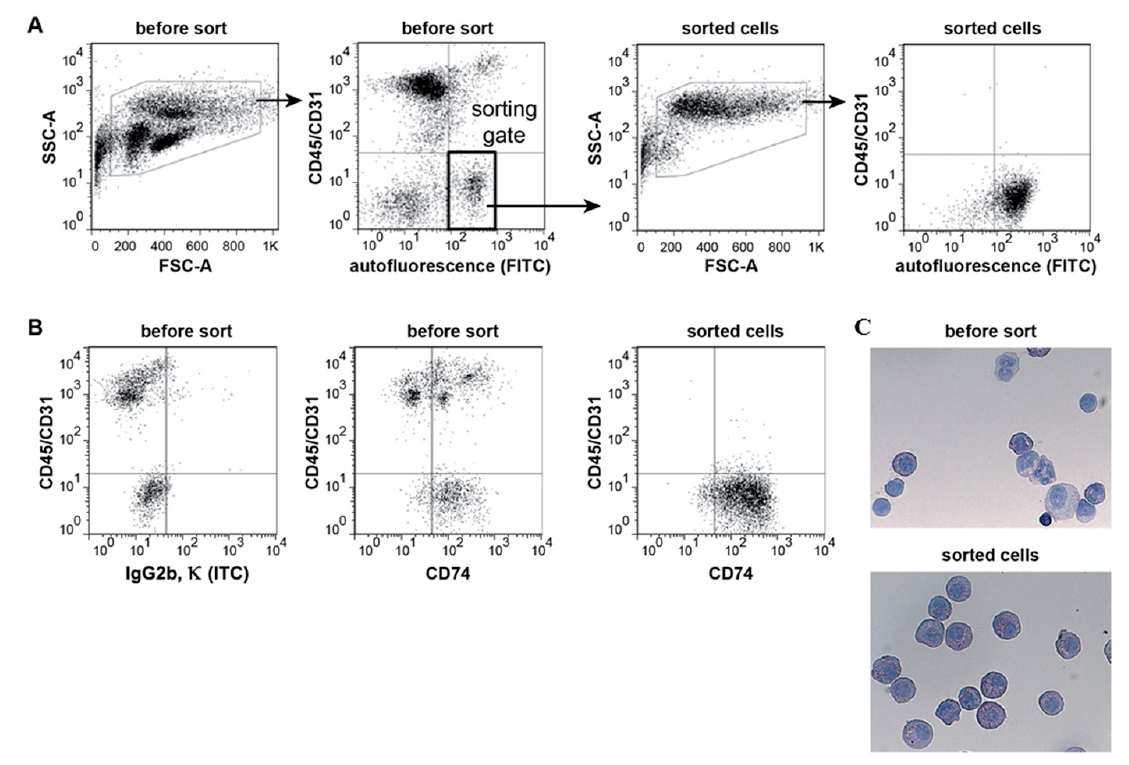
Figure 1. FACS strategy and purity of sorted ATII cells. ( A ) ATII cells were sorted based on high autofluorescence (FITC-channel) and absence of CD45 and CD31 surface expression (left panels). CD45 and CD31 expression levels were measured in the same channel (APC) and the gate used for sorting is highlighted as a thick rectangle. Sorted cells were re-analysed using the same gating strategy (right panels). Removal of doublets based on FSC characteristics not shown. Dot plots are representative of four independent experiments. ( B ) Representative dot plots of cells stained for CD45, CD31 and intracellular CD74 before and after sorting (ITC: isotype control). ( C ) Light microscopic images of Papanicolaou-stained cytospin preparations of cells before and after sorting ( × 400). ATII cells show characteristic dark blue inclusions in the cytoplasm (n = 4, mean ± SEM). Papanicolaou staining (Figure 1C) showed that nearly all of the sorted cells have dark blue inclusions in the cytoplasm (lamellar bodies)—a characteristic feature of ATII cells [59]. 3.2. Confirmation of Epithelial and ATII Identity of the Sorted Cell Population To further corroborate the identity of sorted ATII cells, cytocentrifuge preparations were stained with characteristic ATII and non-ATII phenotypic markers. Sorted cells were highly positive for pro-surfactant protein C (proSP-C) and epithelial cell marker proteins E-cadherin and cytokeratin (Figure 2). On the other hand, the expression of leukocyte marker CD45, endothelial marker CD31 and smooth muscle cell marker α -SMA was not detected in sorted cells. Some very few cells were found to express the Club cell secretory protein (CCSP) after